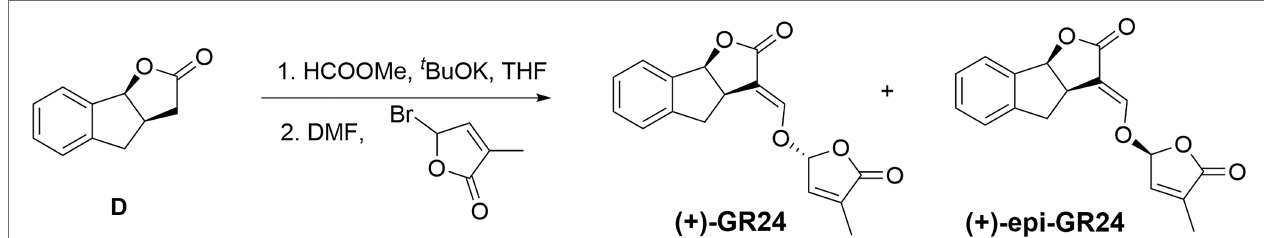
FIGURE 1 | Synthesis of (+)-GR24.